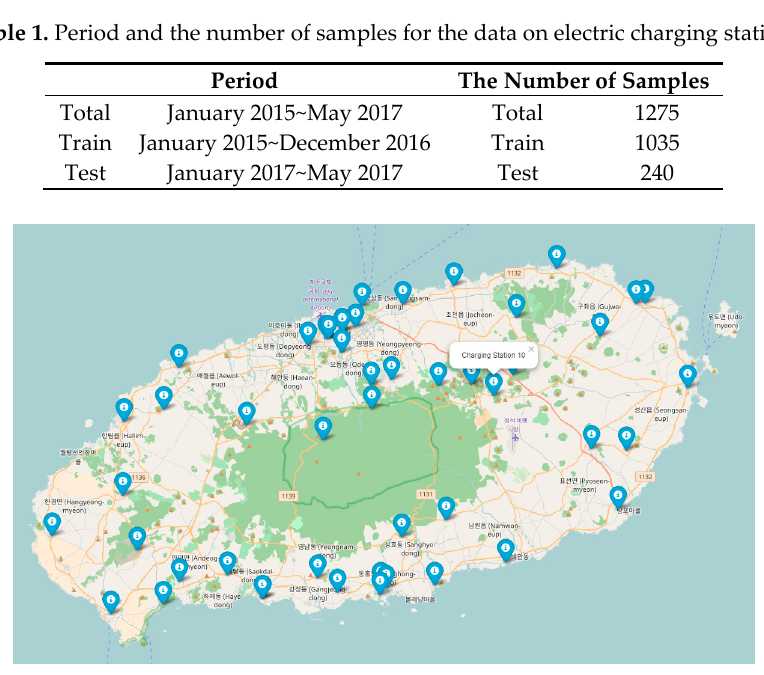
Figure 7. Electric vehicle charging stations on Jeju island used for the experiments.